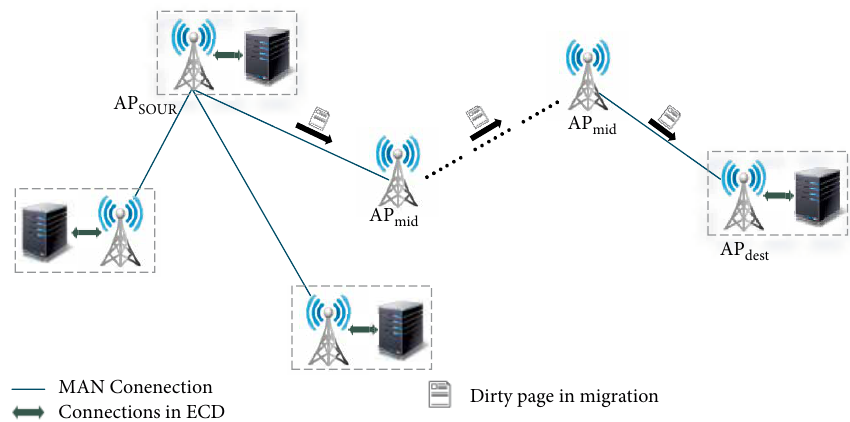
Figure 1: An instance of VM migration in ECD-based complex